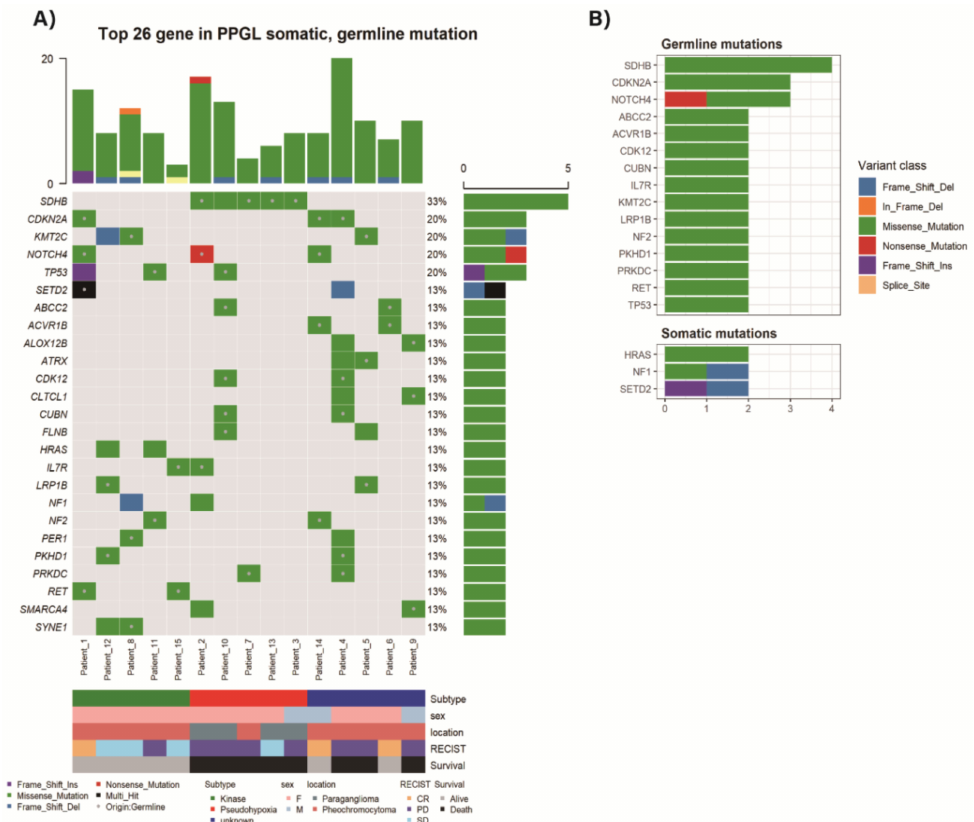
Figure 1. Top 26 altered genes in Asan Medical Center (AMC) pheochromocytomas and paragan- gliomas (PPGLs) with germline or somatic mutation ( A ) Mutations detected by targeted massive parallel sequencing were depicted. Tumor samples are arranged from left to right. The type of mutation is annotated for each sample by the color. Germline mutation is marked as a dot in a square. The mutation frequency is presented in the right of the panel. The mutation number per sample is presented on the top of the panel. ( B ) Most frequently altered germline and somatic